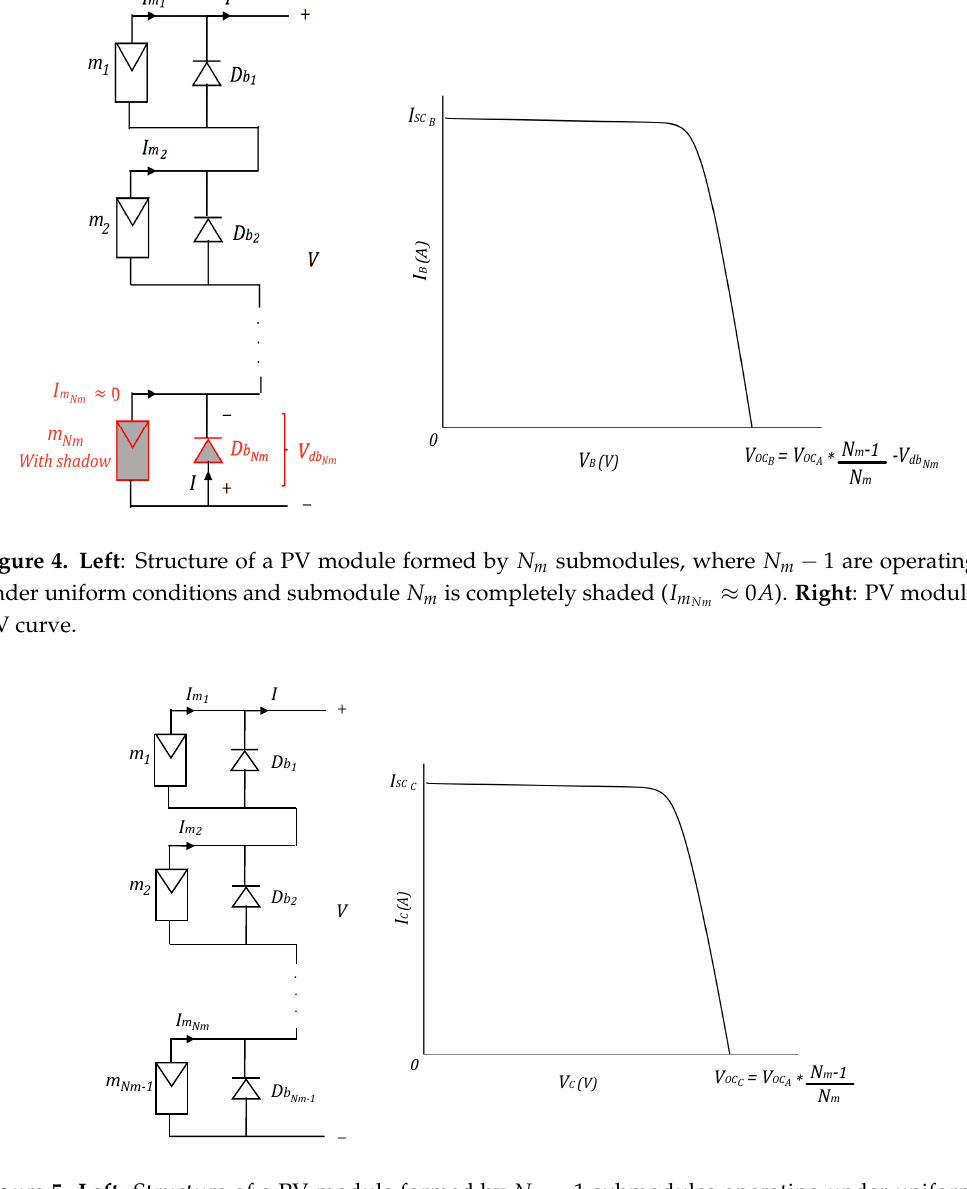
Figure 5. Left : Structure of a PV module formed by N m − 1 submodules operating under uniform conditions. Right : PV module I-V